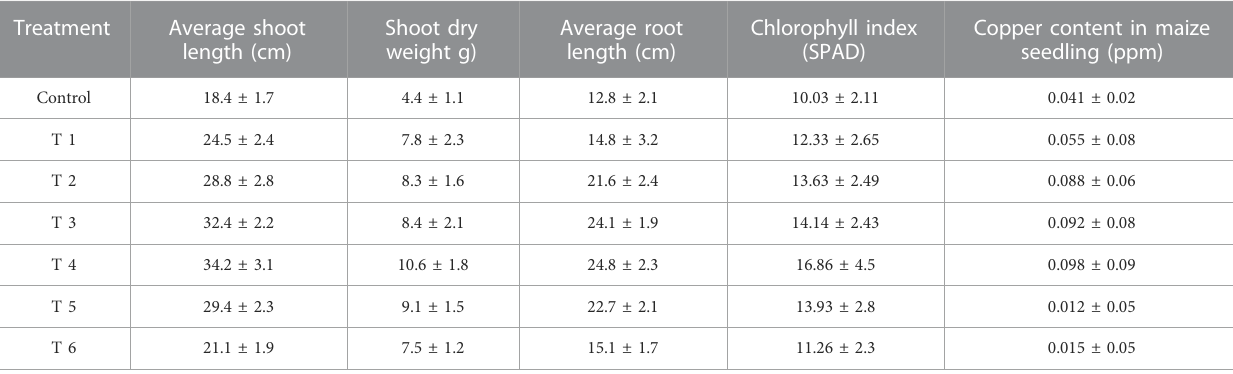
TABLE 2 In vitro studies on the effect of CuO-NPs on growth of maize seedling (Data are means of three replicates ±SD. Data are recorded after 21 days of germination).